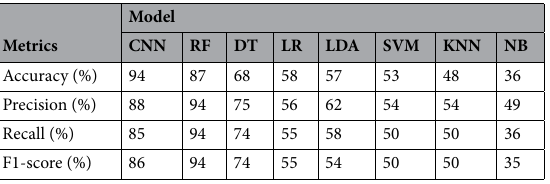
Table 5. Model accuracy, weighted average of precision, recall and F1-score.